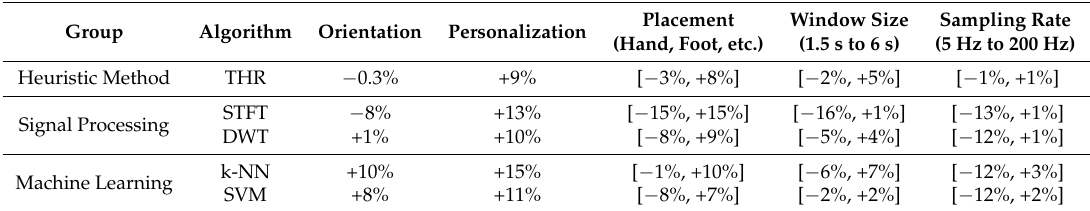
Table 10. WD accuracy under various